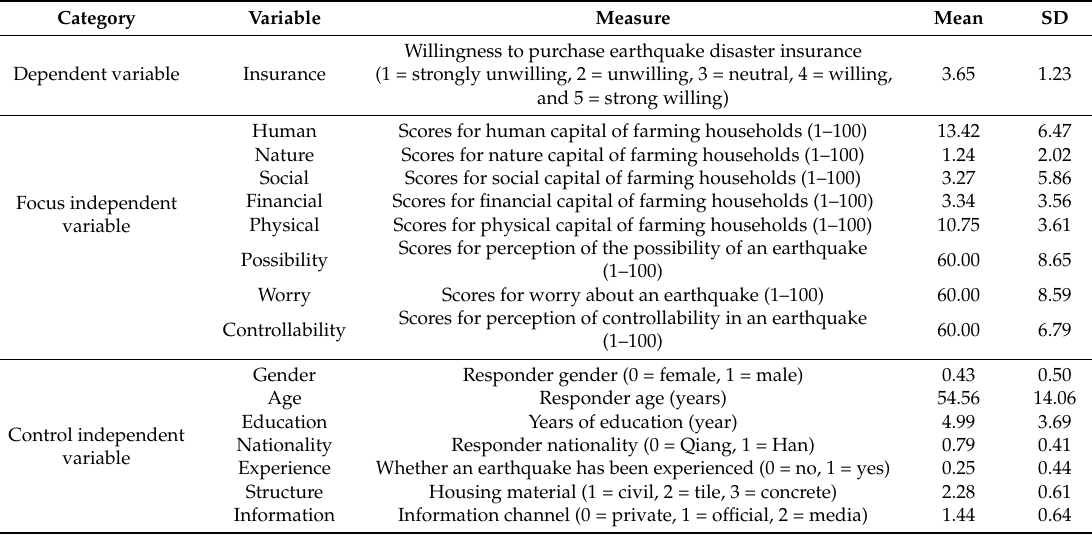
Table 4. Definition and descriptive statistics of the variables in the